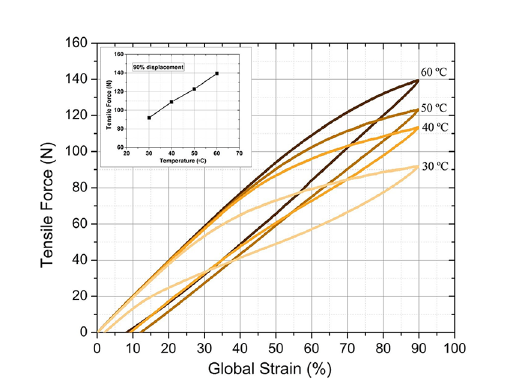
Figure 7. Force vs deflection behaviour for SPG-D2.0 as a function of temperature. were based on previous characterization studies of shape memory alloys 37 .